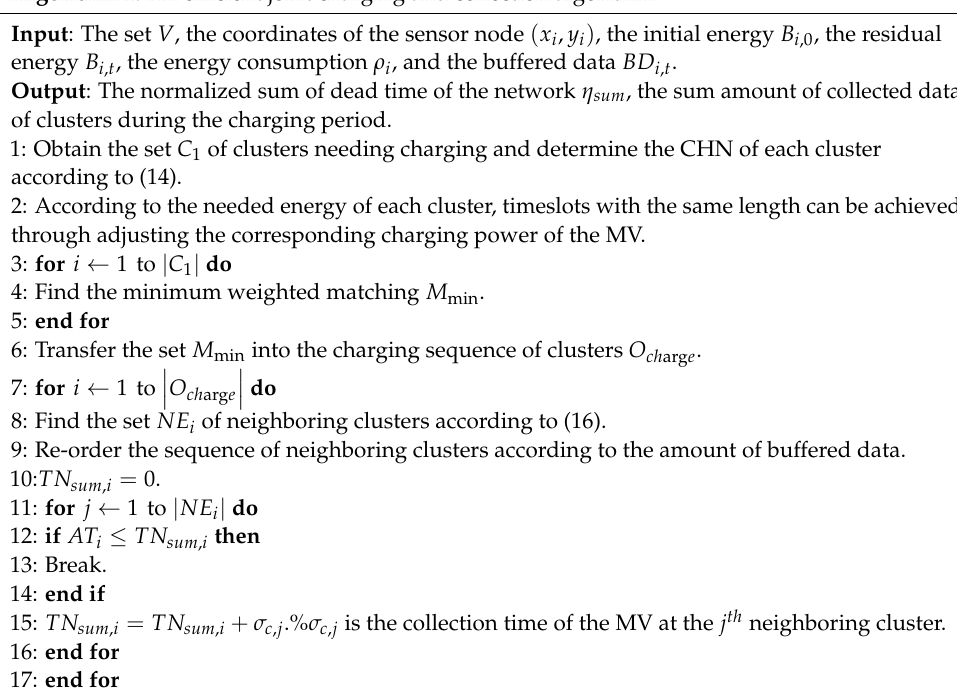
Algorithm 1. An efficient joint charging and collection